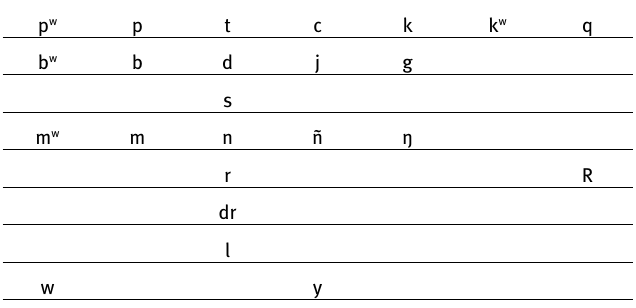
Table 1: Proto-Oceanic